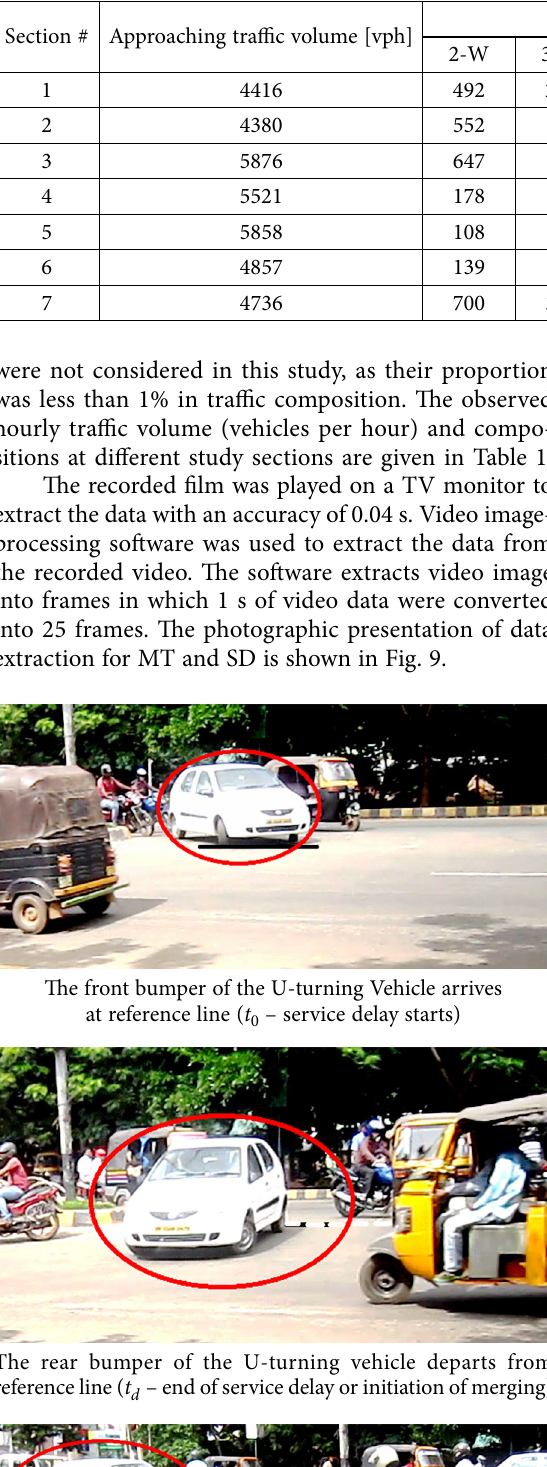
Table 2. Distance of merging line for different categories of vehicles